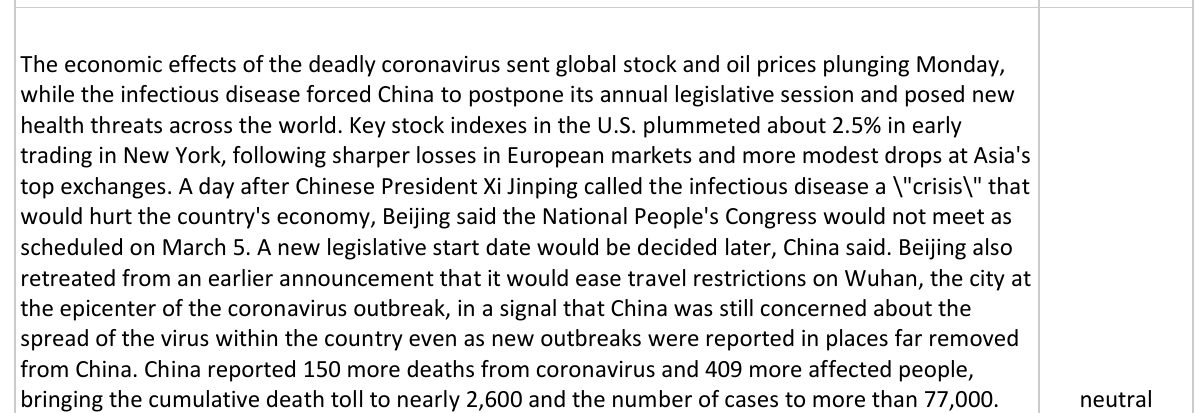
Table 3 : U.S. government-funded